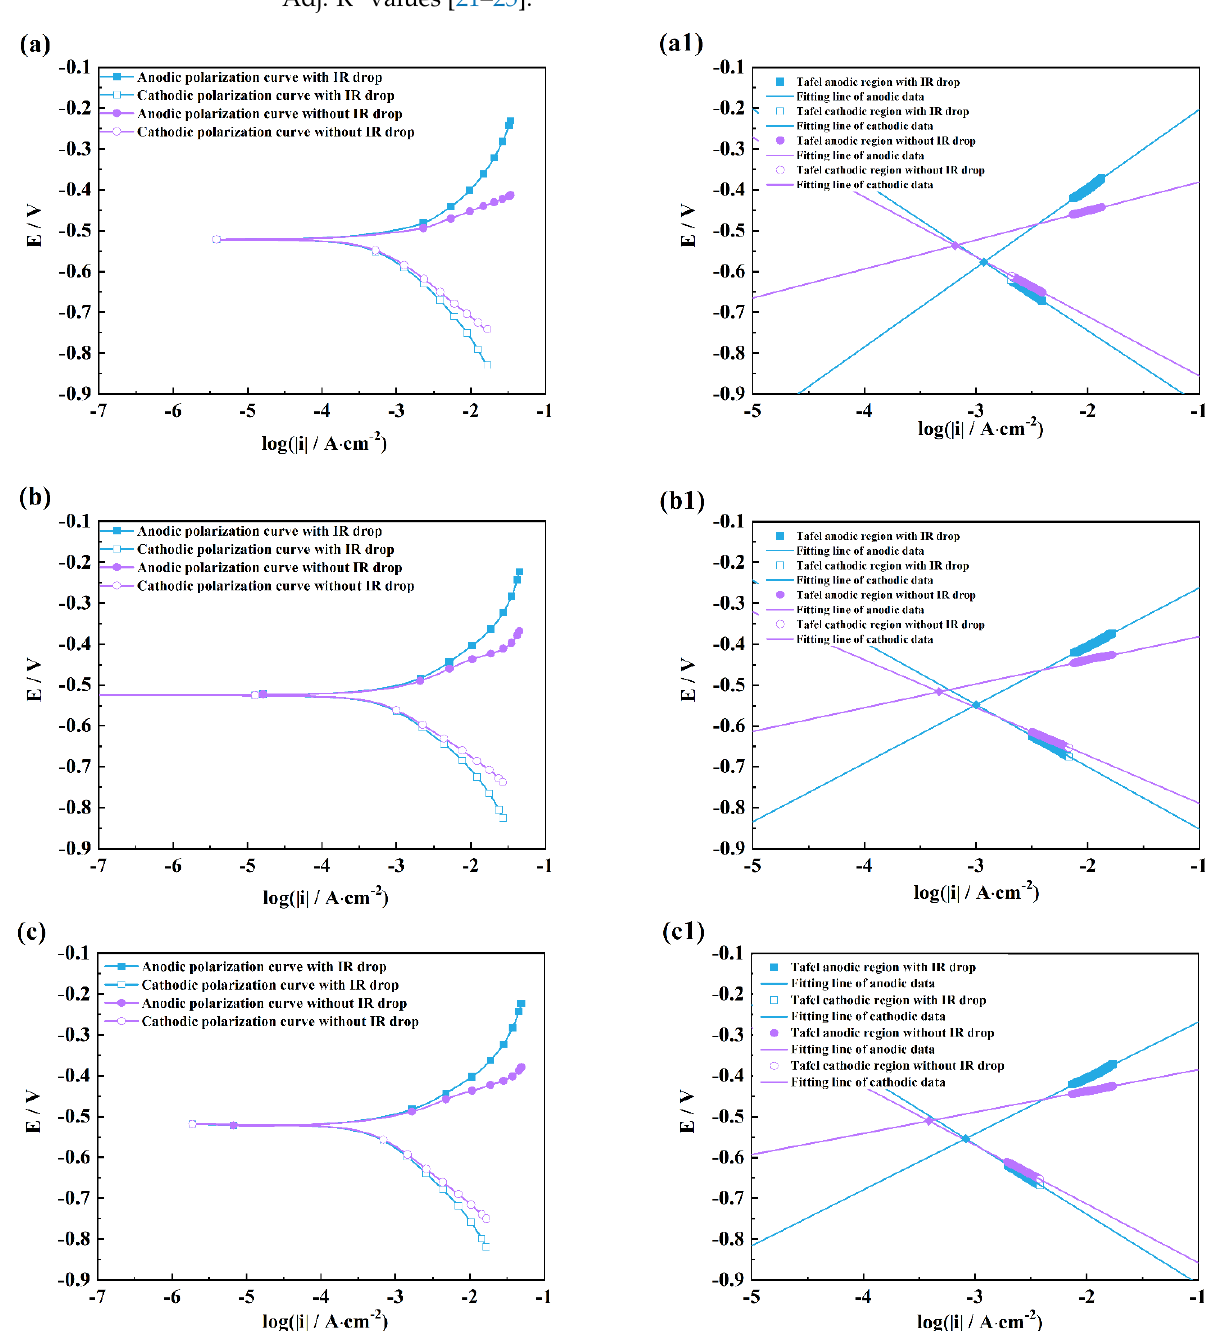
Figure 3. The equivalent electric circuit of the metal–solution interface.